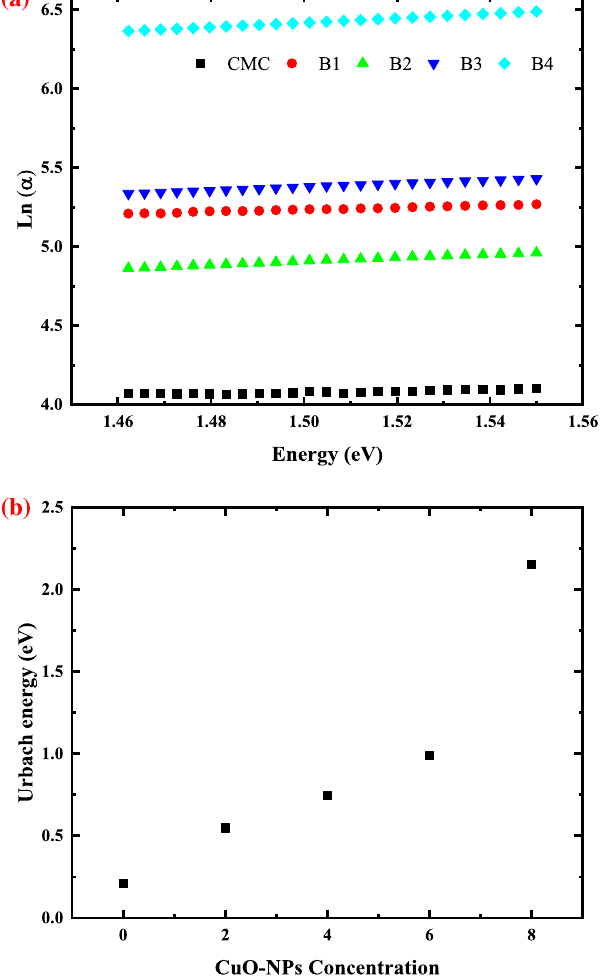
Figure 7. ( a ) Plotting of lnα as a function of photon energy (hυ) for pure CMC and CMC with different concentration of CuO-NPs and ( b ) variation of Urbach energy with CuO-NPs